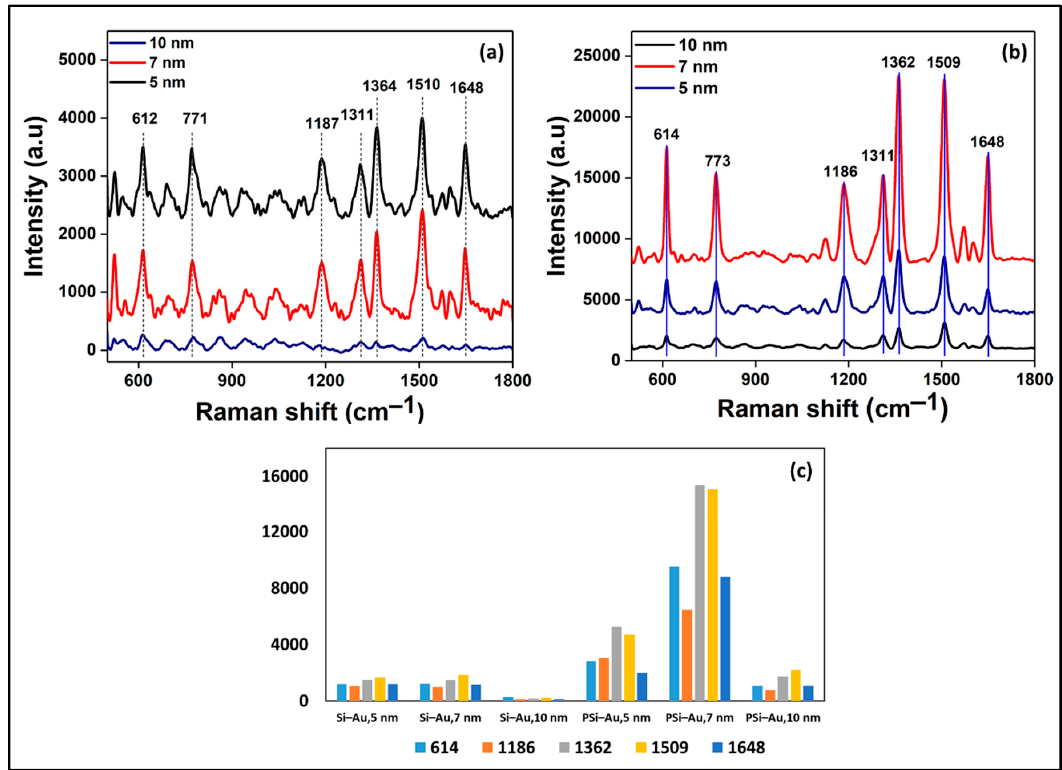
Figure 6. SERS spectra of 1 × 10 − 6 M solution of R6G adsorbed onto the surface of ( a ) Si and ( b ) PSi coated with 5, 7, and 10 nm Au thin films. ( c ) Comparison of the SERS peak intensities of the six different composites.